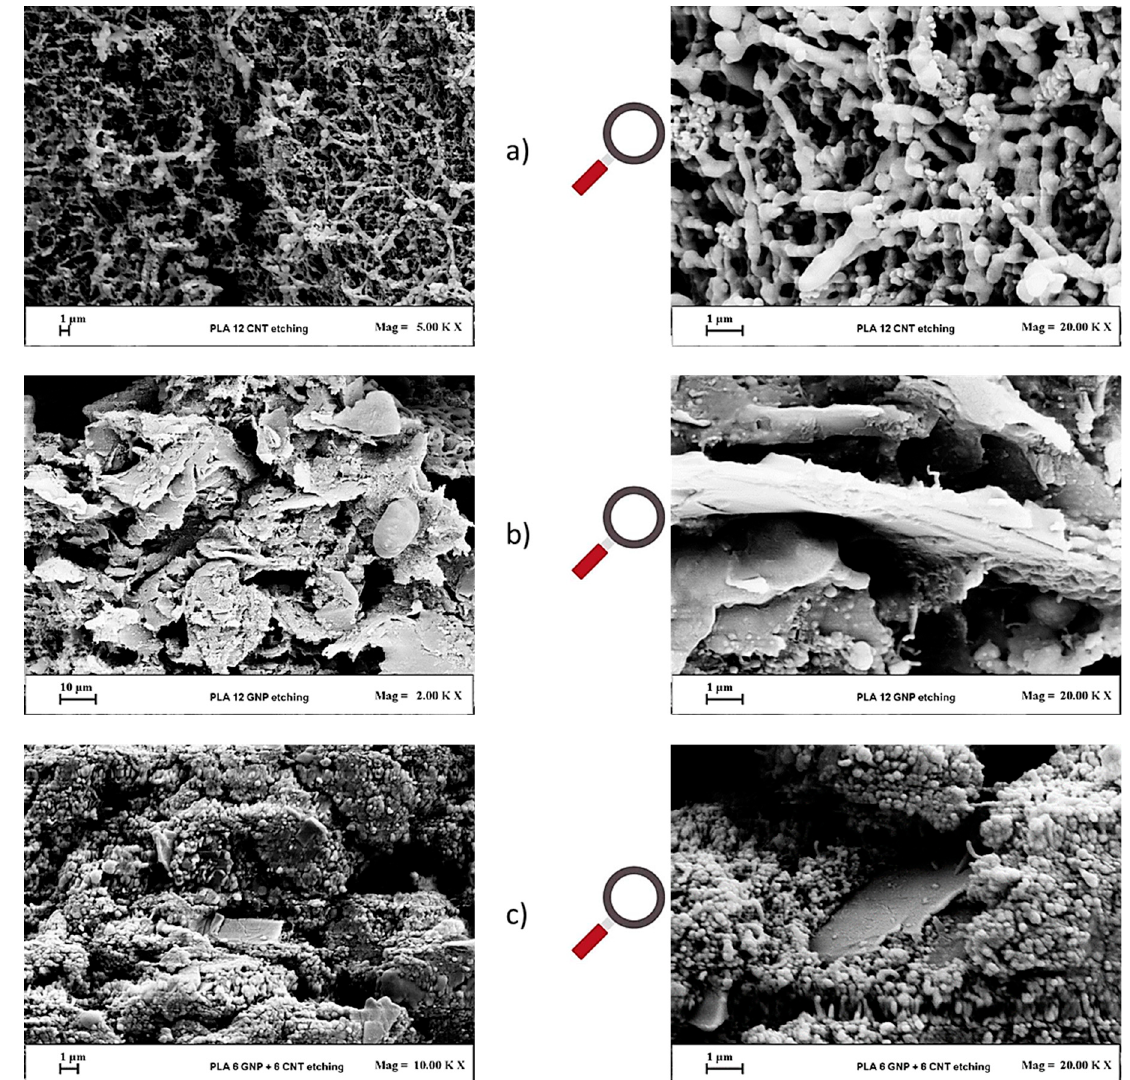
Figure 7. SEM micrographs of nanocomposite at the highest filler concentration, i.e., 12 wt %. In more detail, ( a ) multiwall carbon nanotubes (MWCNTs)-based composites; ( b ) graphene nanoplates (GNPs)-based composites; ( c ) multiphase composites filled with both fillers (MWCNTs + GNPs 1:1). In the left column are low magnifications at 2–10 K and in the right column are their respective magnification at 20 K (1 µm scale).